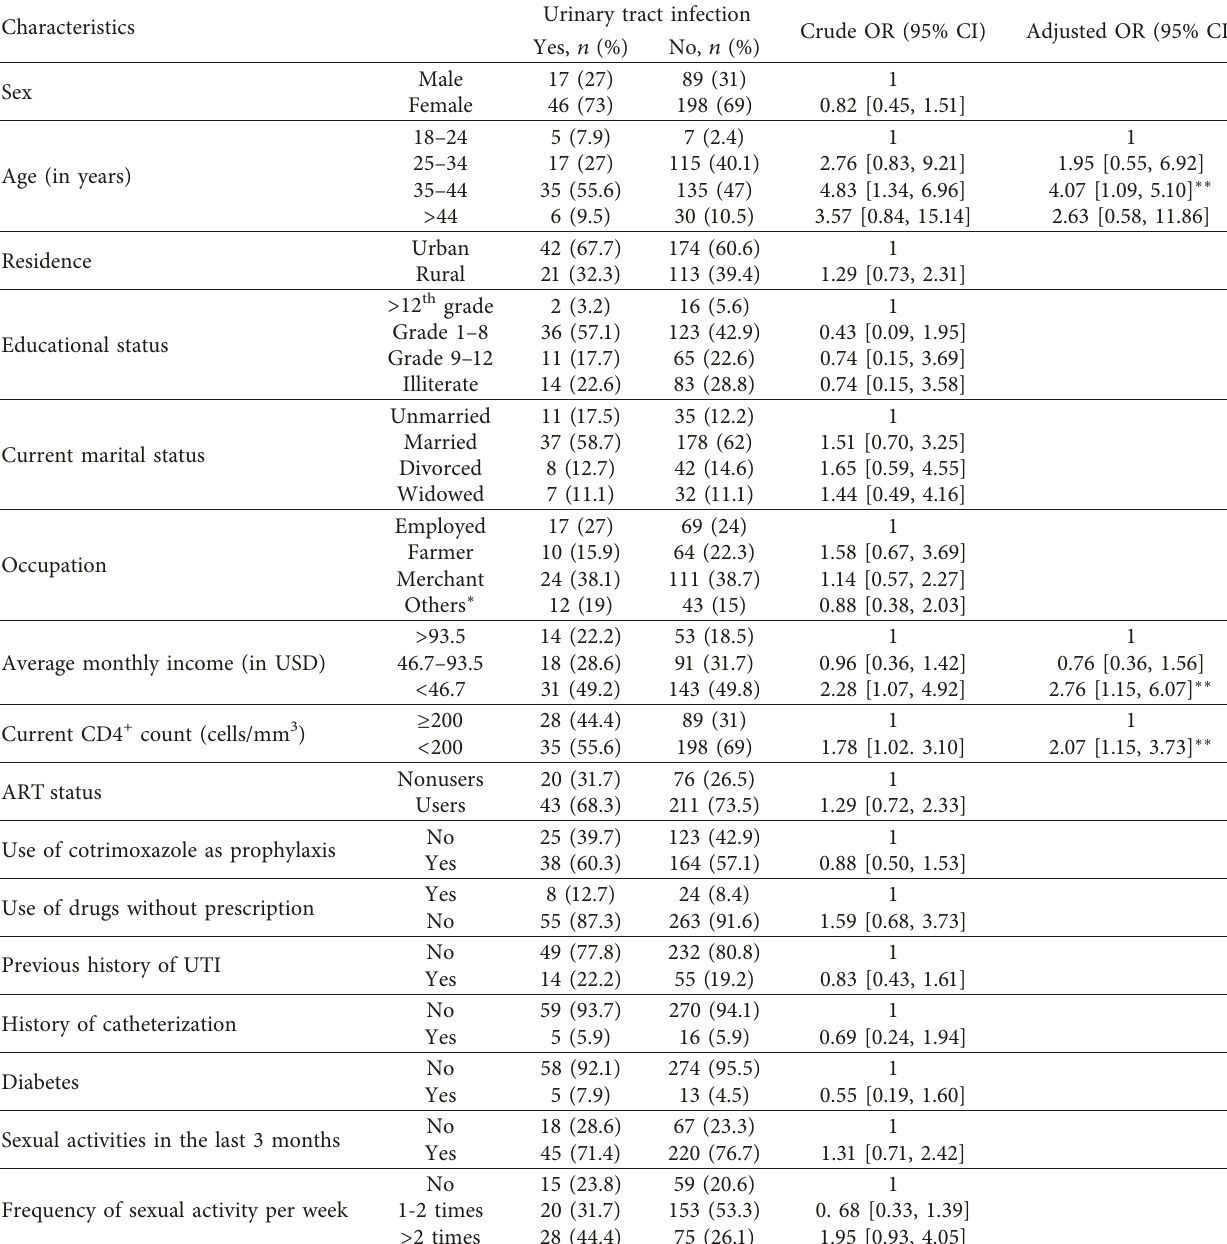
Table 3: Distribution of UTI by associated factors among HIV-positive patients at Hiwot Fana Specialized University Hospital, Eastern Ethiopia,